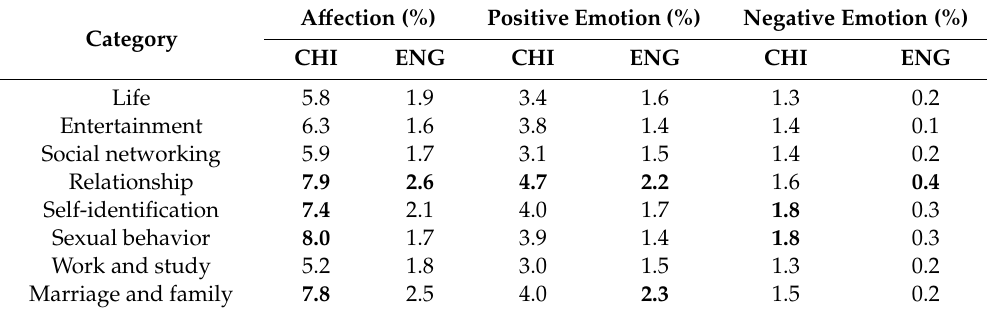
Table 4. A ff ection scores of each category calculated by LIWC programs.